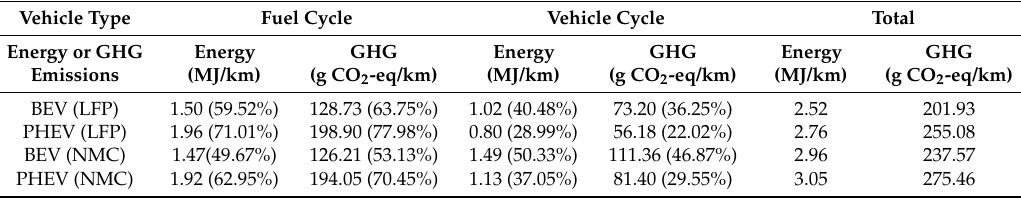
Table 8. Energy consumption and GHG emissions in the life cycle.